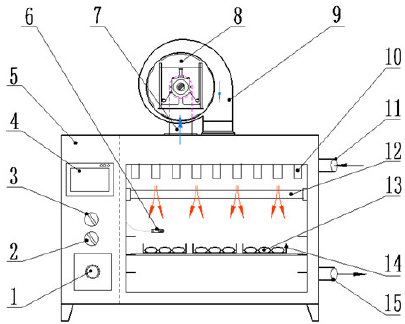
Figure 4. Structure diagram of medium- and short-wave infrared drying equipment (The arrows indicate the direction of airflow). (1) Fan switch, (2) power supply control switch, (3) lamps switch, (4) touch screen, (5) control cabinet, (6) temperature sensor, (7) return air duct, (8) centrifugal fan, (9) air inlet duct, (10) spray nozzle, (11) air inlet port, (12) infrared heating tubes, (13) samples, (14) stainless-steel tray, (15) wet discharging port.